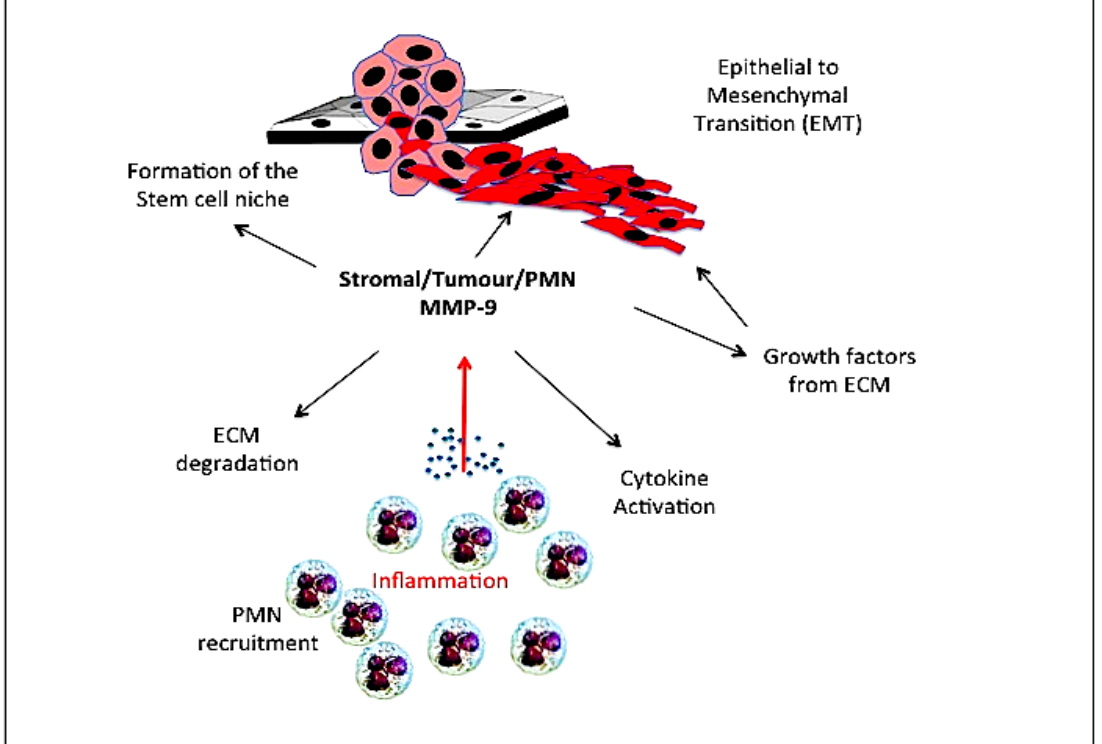
Figure 3. Representation of the role played by inflammatory polymorphonuclear leukocyte (PMN), stromal and tumour cell-derived gelatinase B/MMP-9 in epithelial-mesenchymal transition (EMT) and formation of the stem cell niche through degradation of extracellular matrices (ECM) release and activation of cytokines and growth